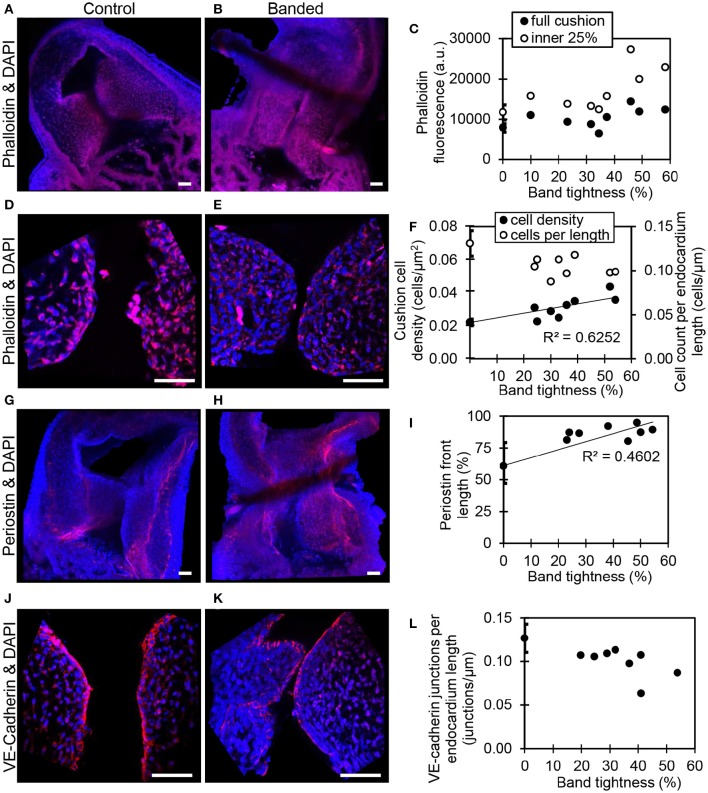
Confocal fluorescent image analysis with banding. Phalloidin (red) stain at 20x in a control (A) and banded outflow tract with 52% band tightness (B), with phallodin fluorescence intensities quantitated in (C). Phalloidin (red) stain at 63x in a control (D) and banded outflow tract with 52% band tightness (E), with cushion cell density and cell count per endocardium length quantitated from DAPI stain (F). Periostin (red) labeling at 20x in a control (G) and banded outflow tract with 49% band tightness (H), with periostin front length quantitated in (I). VE-cadherin (red) labeling at 63x in a control (J) and banded outflow tract with 41% band tightness (K), with endocardial cell junctions per endocardium length quantitated in (L). Each sample is also stained with DAPI (blue). 0% band tightness refers to the control group. Scale bar = 50 microns.